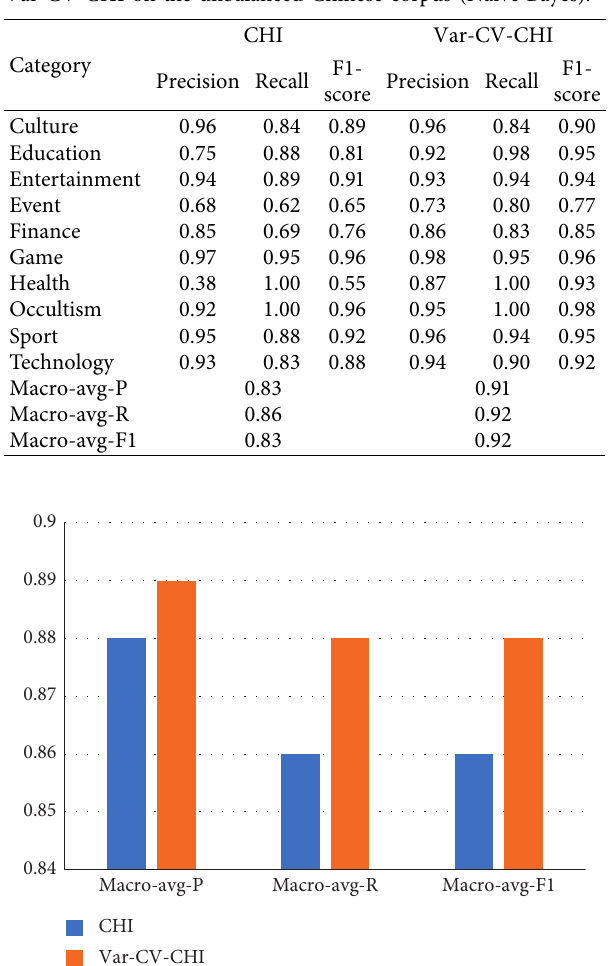
Table 7: Comparison of classification results between CHI and